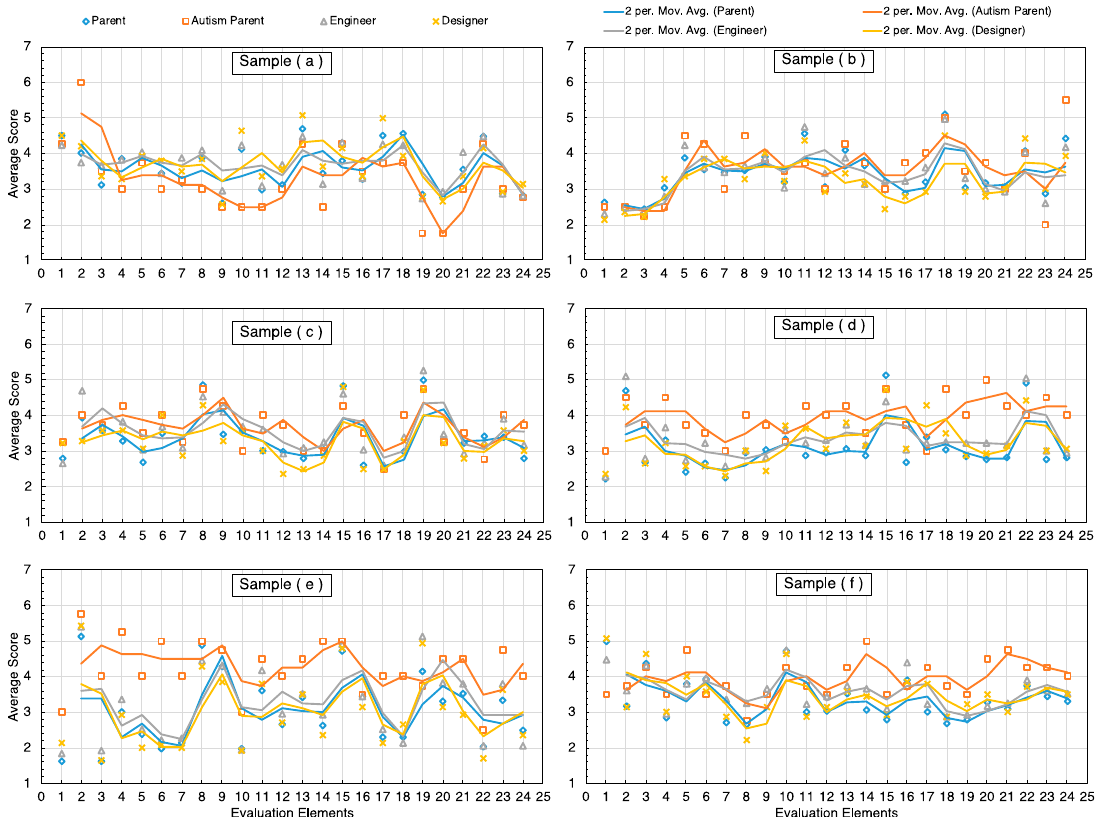
Figure 8. Differences in evaluation results among the four groups. The scoring indexes of each